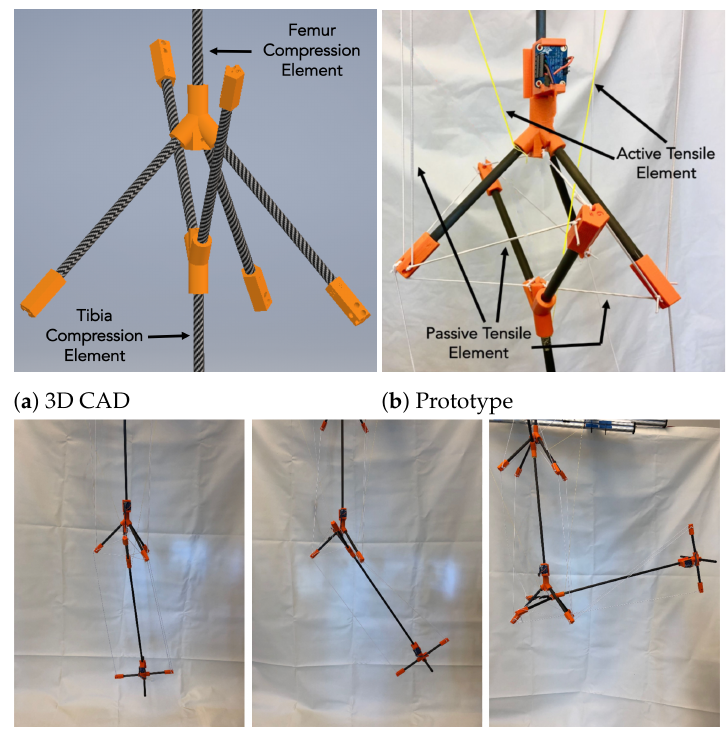
Figure 3. Tensegrity Flexural Joint: